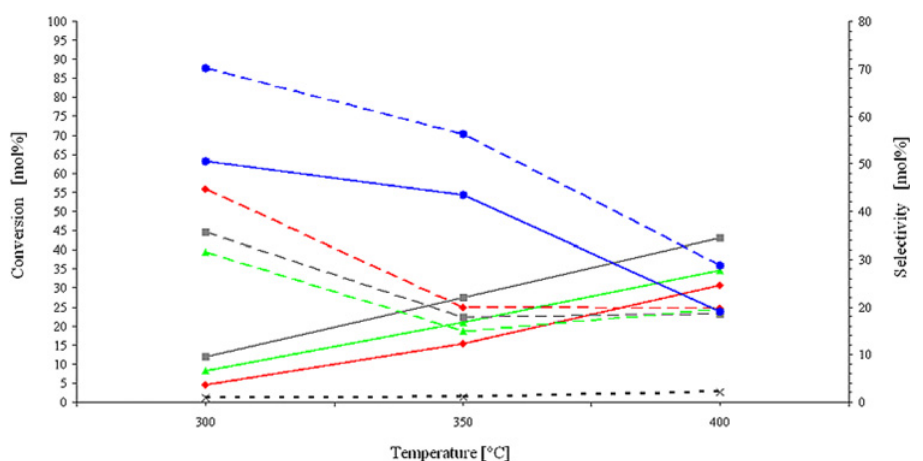
Fig 6. Glycerol conversion (solid lines) and selectivity (dashed lines) vs. temperature, 1.0% Au/Fe ( & ), 1.0% Au/Ni ( ▲ ), 1.0% Au/Cu ( ● ) and 1.5% Au/SiO 2 ( ♦ ). The dotted lines refer to the yield of 1-hydroxyacetone; black dotted line ( x ) – the total conversion of the blank sample, solid lines describe glycerol conversion. Reaction conditions: 200 mg of catalyst (10.0 – 15.0 μ mol Au), 300 – 400°C, glycerol concentration 13.6 mol/L and nitrogen flow 0.3